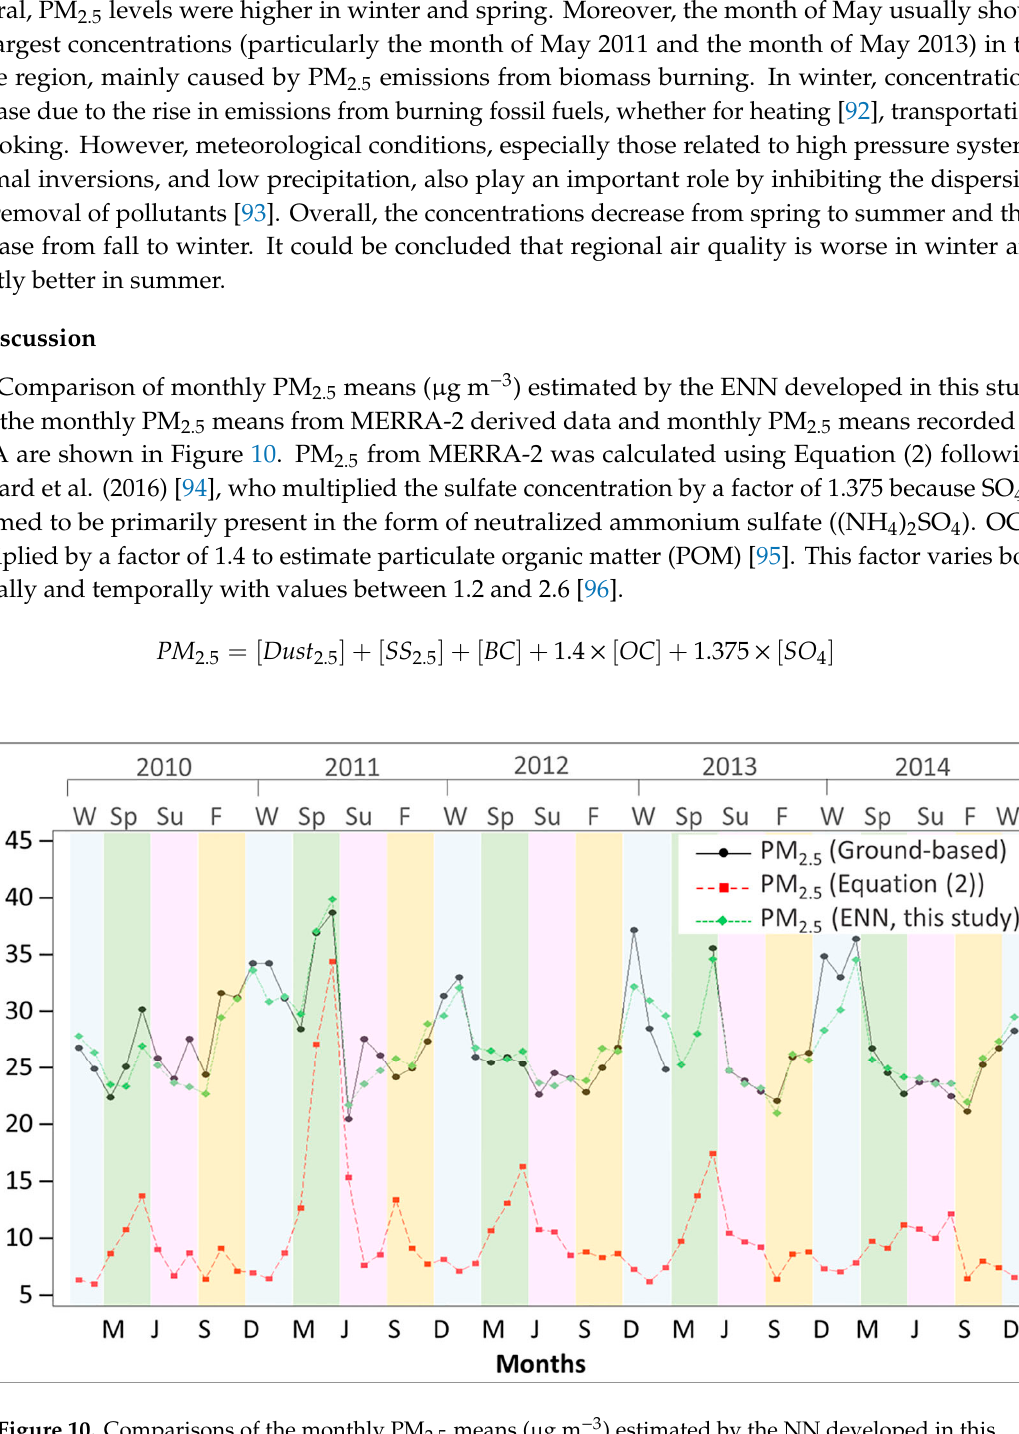
Figure 10. Comparisons of the monthly PM 2.5 means ( μ g m –3 ) estimated by the NN developed in this study, MERRA-2 derived data, and SIMA data. Seasons: W: Winter, Sp: Spring, Su: Summer, F: Fall. Months: M: March; J: June, S: September, D: December.